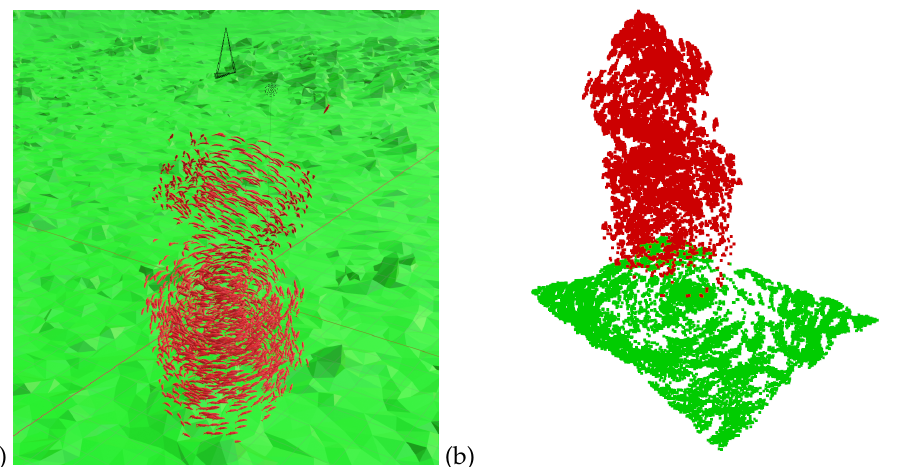
Figure 19. ( a ) The 3D mesh representation with colored material for segmentation with virtual sonar sensor (top), ( b ) segmented point cloud with fish (red) and ground (green)